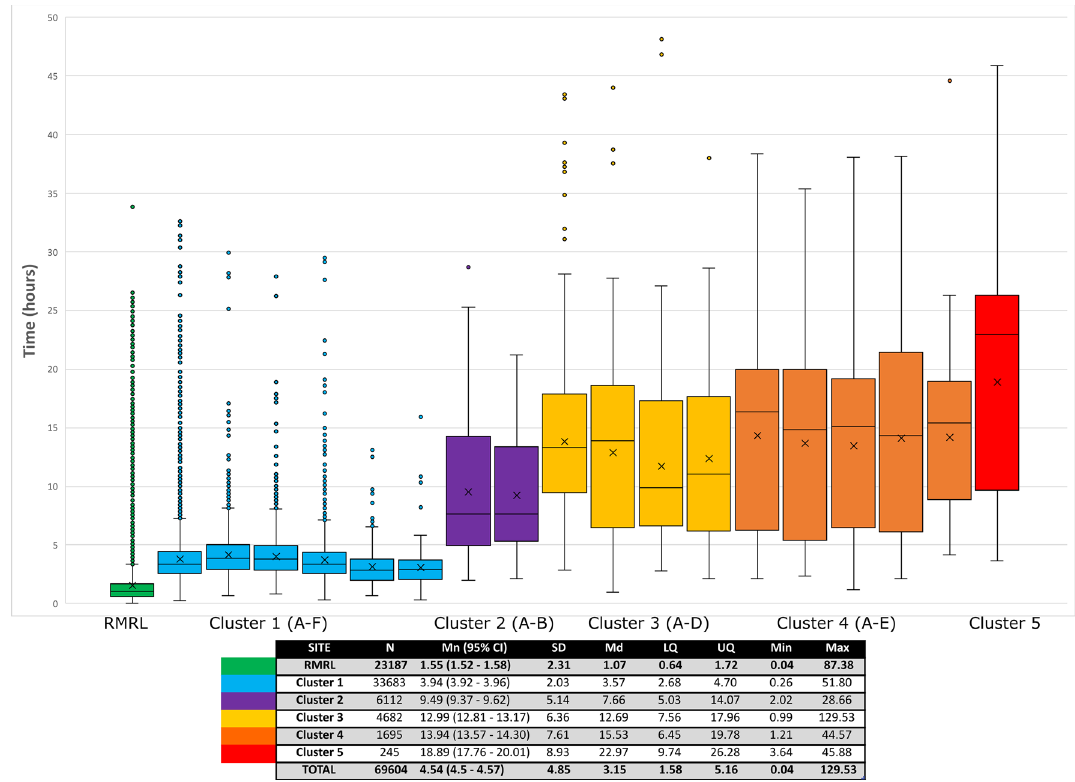
Figure 2. Distribution of preincubation times (h) per sites, showing interquartile ranges. Data points between 0 and 50 h are represented on the figure. Data series are presented in alphanumerical order of clusters and sites. Outlier points as per the 1.5 × IQR rule are included on the graphic. X: mean. Inset: mean preincubation times (h) for all sites clusters with standard deviation, median and lower/upper quartile). N: number of samples, Mn: mean, CI: confidence interval, SD: standard deviation, Md: median, LQ: lower quartile, UQ: upper quartile, Min: minimum, Max: